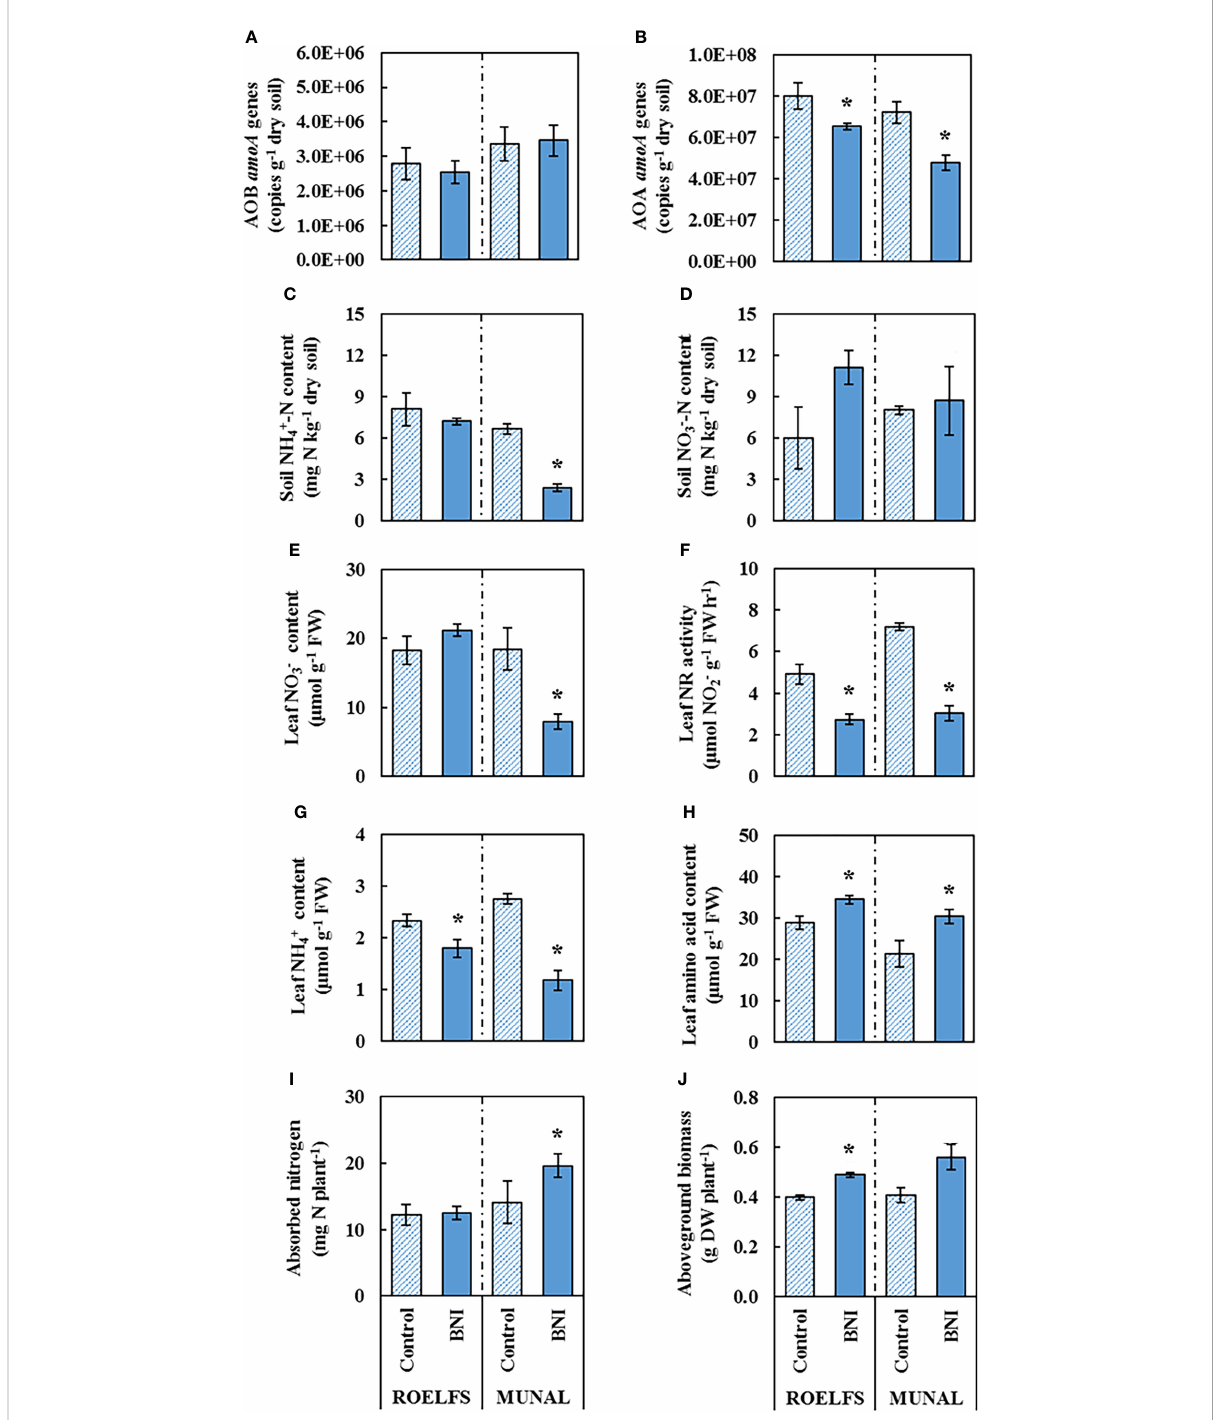
FIGURE 4 Performance of Control and BNI-isogenic-lines from ROELFS and MUNAL fertilized with ammonium sulphate + DMPP (AS+D) . Soil and plant parameters were measured 30 days post-fertilization (T30): Abundance of AOB (A) and AOA (B) , soil mineral nitrogen content such as ammonium (C) and nitrate (D) . and leaf determination of nitrate content (E) , nitrate reductase activity (F) . ammonium content (G) , amino acid content (H) , absorbed nitrogen (I) , and aboveground biomass (J) . The Mann-Whitney U test was used for the comparison between the absence or the presence of BNI-trait and the signi fi cant differences at p <0.05 are marked with an asterisk